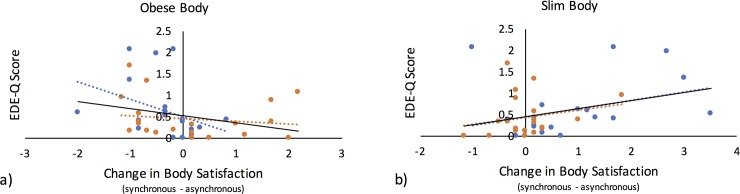
Body size x synchrony x EDE-Q interaction.a) Decreases in explicit body satisfaction were correlated with EDE-Q score in the obese body condition, in which higher cognitive-behavioural eating disorder characteristics were associated with greater reductions in body satisfaction. This relationship survived for females (blue circles) but not for males (orange circles). b) Increases in body satisfaction correlated with EDE-Q score in the obese body condition, in which higher cognitive-behavioural eating disorder characteristics were associated with greater increases in body satisfaction. This relationship did not survive for females (blue circles) or males (orange circles) when examined independently.